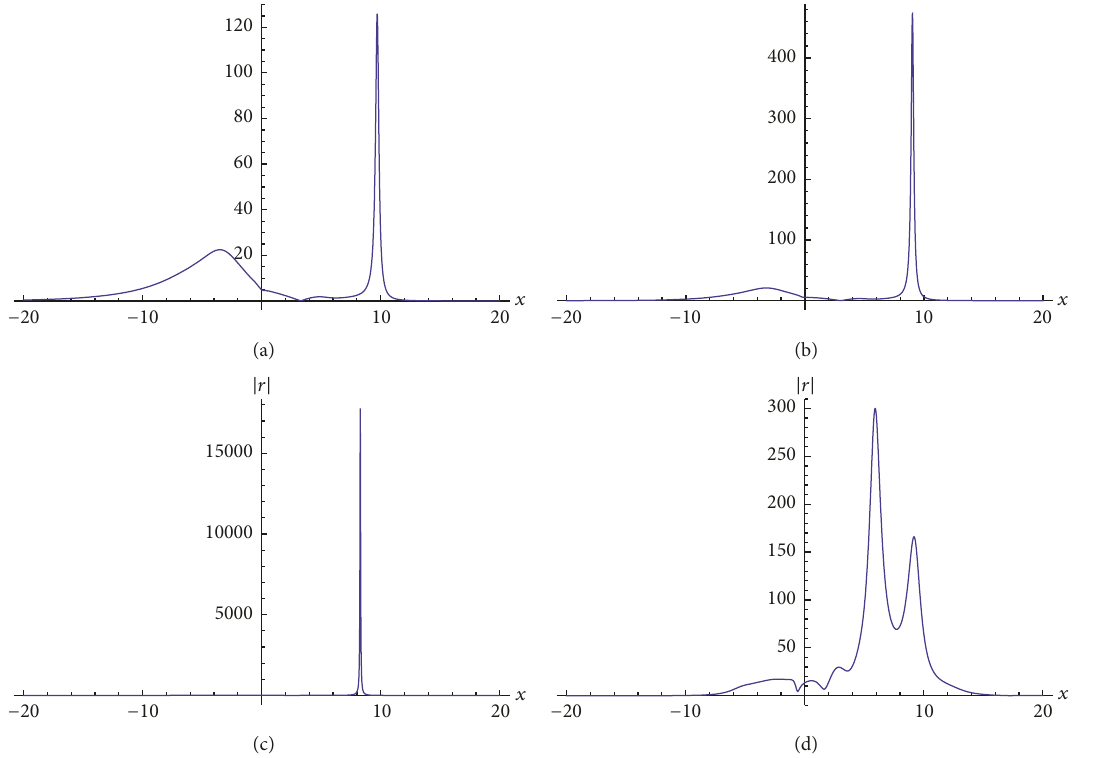
Figure 4: Dynamical evolutions of two-soliton solution determined by (66) at different times: (a) 𝑡 = 2.8 , (b) 𝑡 = 2.9 , (c) 𝑡 = 3 , and (d) 𝑡 = 3.3